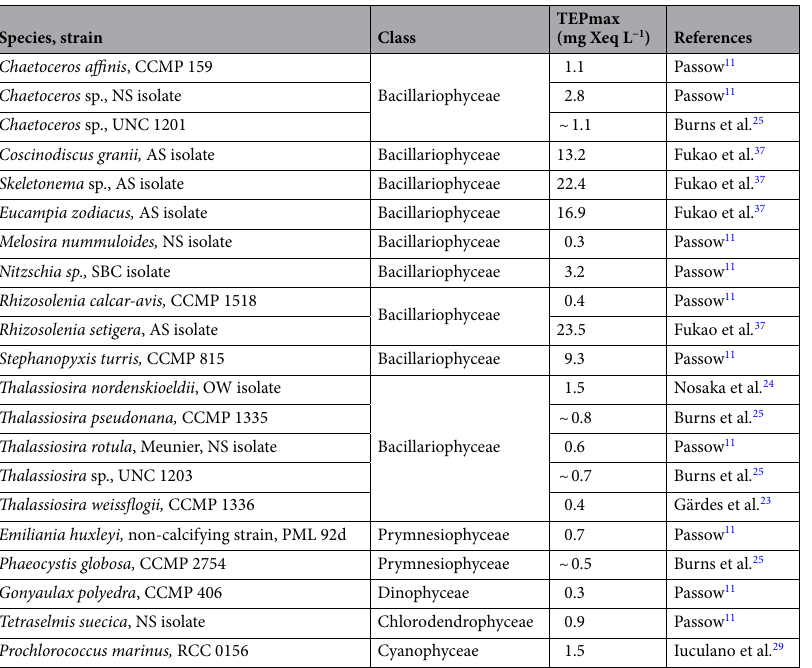
Table 3. Maximum TEP concentration (TEPmax; mg Xeq L −1 ) produced by different phytoplankton species grown in cultures (mostly non-axenic). CCMP Provasoli-Guillard National Center for Culture of Marine Phytoplankton, PML Plymouth Marine Laboratory, UNC University of North Carolina, RCC Roscoff Culture Collection, NS North Sea isolate, SBC isolated from the Santa Barbara Channel, off California, AS Ariake Sound isolate (Japan), OW Oyashio Waters